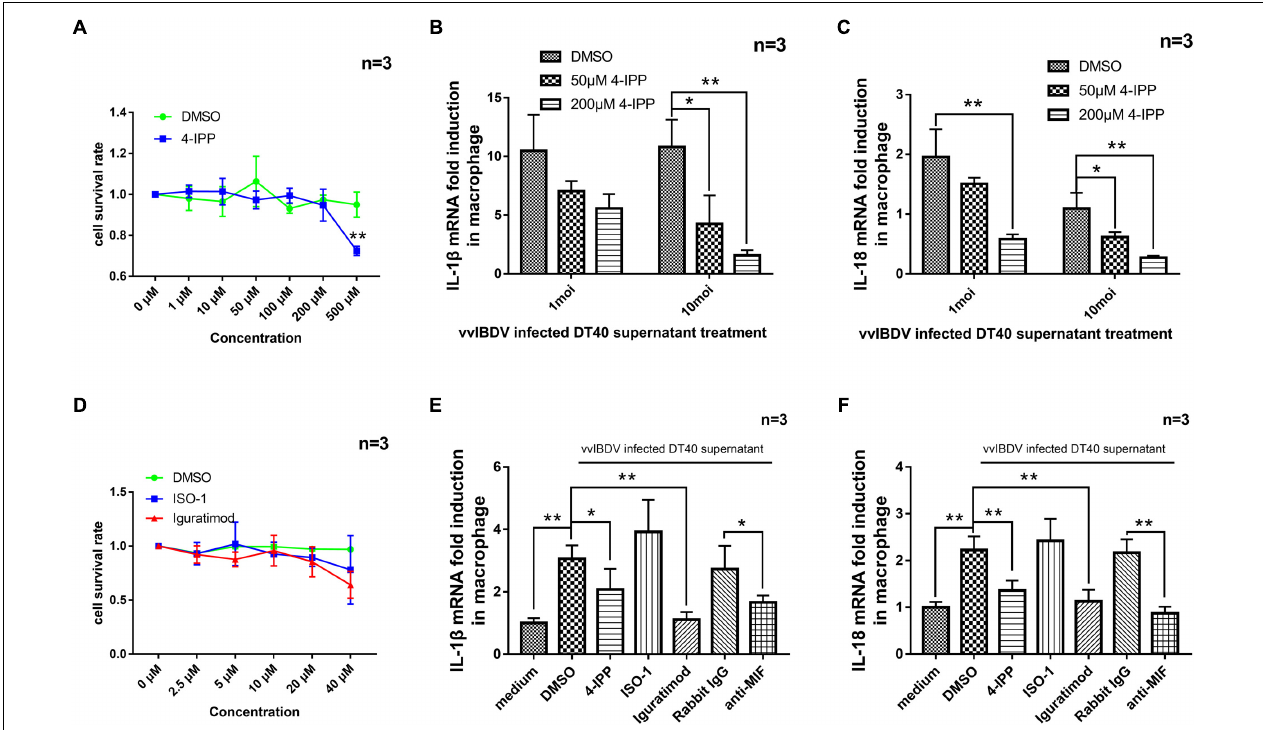
FIGURE 6 | The migration of peripheral blood mononuclear cells (PBMCs) caused by very virulent infectious bursal disease virus (vvIBDV)-infected cell supernatant could be inhibited by macrophage migration inhibitory factor (MIF) inhibitor. (A) Different concentrations (1, 10, 50, 100, 200, and 500 µ M) of iodo-6-phenylpyrimidine (4-IPP) or equal volume of DMSO solvent were added to primary macrophages, followed by assay for cell viability using CCK-8. (B,C) 4-IPP at concentrations of 50 or 200 µ M was incubated with vvIBDV-infected cell culture medium (24 h.p.i.) and then added to macrophages for 24 h. The mRNA levels of IL-1 β (B) and IL-18 (C) were then determined by quantitative polymerase chain reaction (qPCR). ∗ P < 0.05 compared with control groups. (D) Different concentrations (2.5, 5, 10, 20, and 40 µ M) of ISO-1, iguratimod, or equal volume of DMSO solvent were added to primary macrophages, followed by assay for cell viability using CCK-8. (E,F) A total of 20 µ M of 4-IPP, 10 µ M of ISO-1, iguratimod, or 50 µ g/ml anti-MIF antibody were incubated with 10 multiplicity of infection (MOI) vvIBDV-infected cell culture medium (24 h.p.i.) and then added to macrophages for 24 h. The mRNA levels of IL-1 β (E) and IL-18 (F) were then determined by qPCR. ∗ P < 0.05 and ∗∗ P < 0.01 compared with control